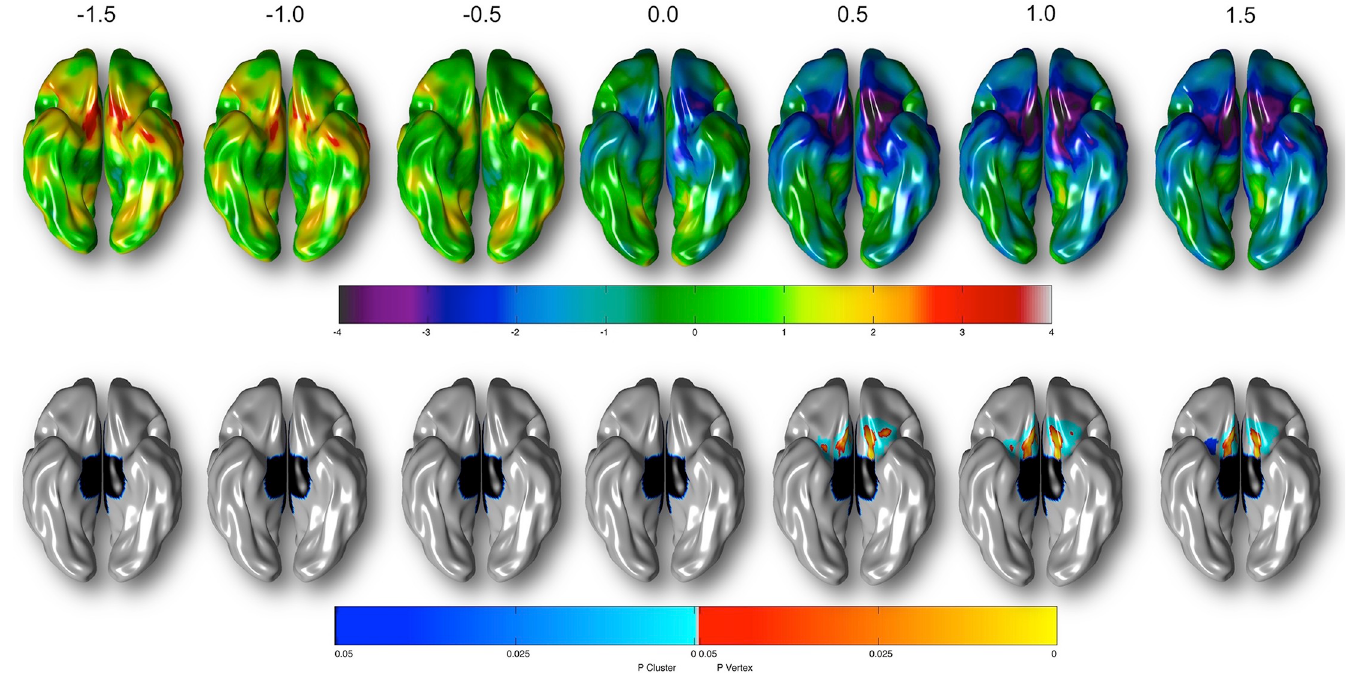
Fig 2. Association between amygdalar reactivity and cortical thickness at varying contrast levels. Relationship between cortical thickness and angry minus neutral face contrast value (averaged across bilateral amygdalar ROI) at varying levels of angry minus neutral face contrast values (-1.5, -1.0, -0.5, 0.0, 0.5, 1.0, 1.5). In top row, colors represent t-statistic values associated with regression coefficient. Bottom row depicts RFT-corrected results ( p � 0.05). Blue areas are significant at the cluster level and red color corresponds to areas significant at the vertex level. Controlled for age, total brain volume, sex, site, handedness, Performance IQ, Verbal IQ, SES and pubertal